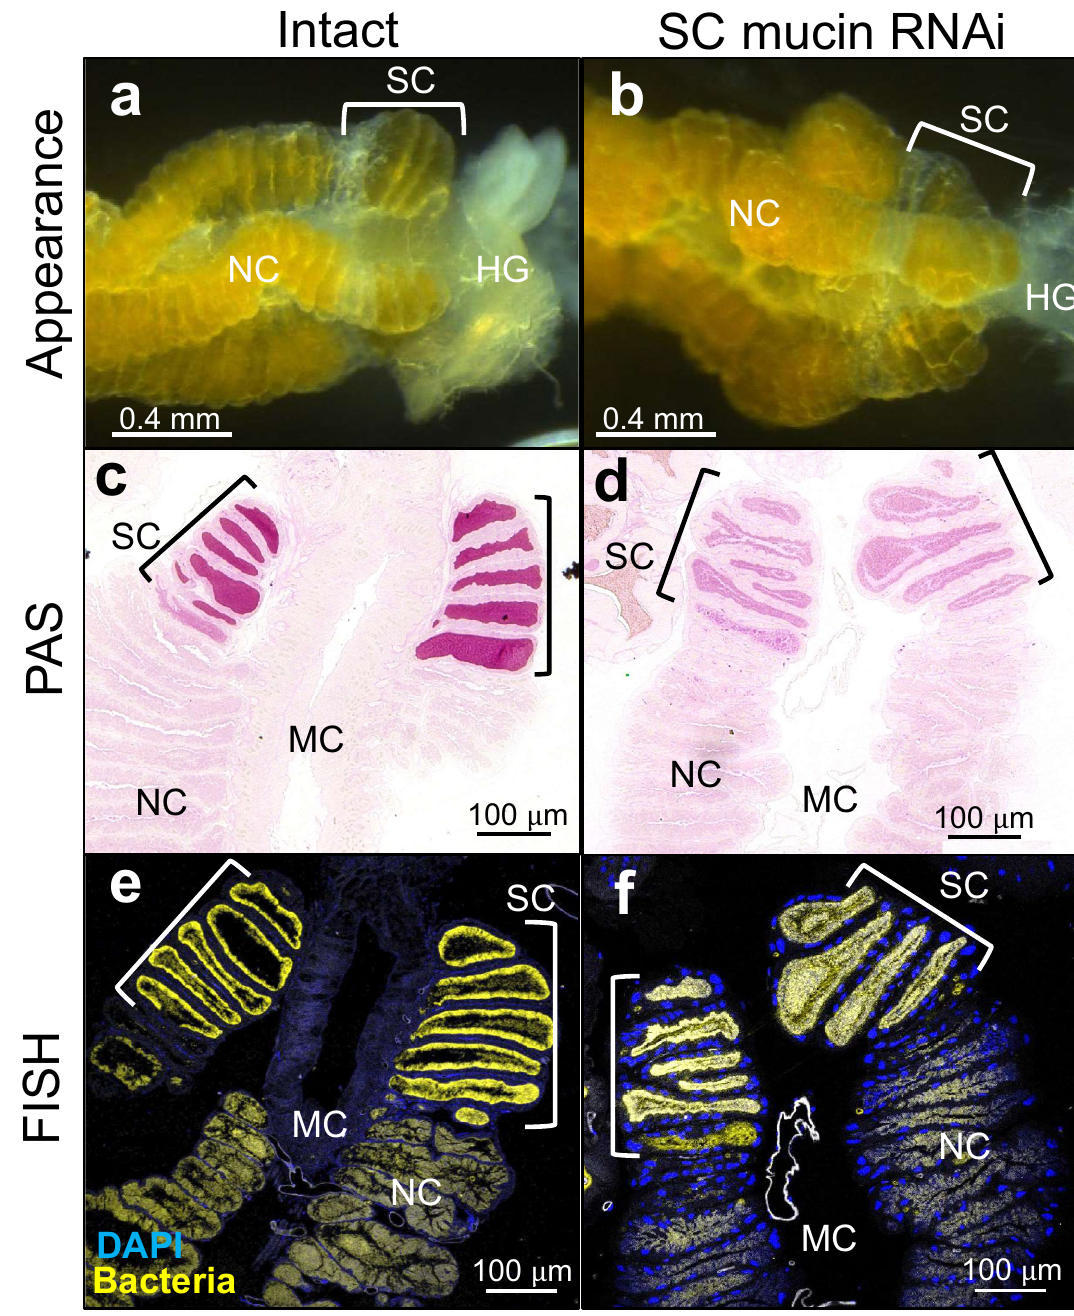
Figure 7. Phenotypic effects of SC mucin RNAi on the symbiotic midgut of adult females. ( a , b ) External appearance of the posterior end region of the symbiotic midgut. ( c , d ). PAS staining of tissue sections on which localization of SC mucin protein is visualized. ( e , f ) FISH of tissue sections on which the symbiotic bacteria are visualized. ( a , c , e ) Control insects without treatment. ( b , d , f ). SC mucin RNAi insects. Adult females 14 days after the treatment were dissected and subjected to morphological and histological inspections. NC, normal crypts; SC, swollen crypts; HG, hindgut; MC, midgut main